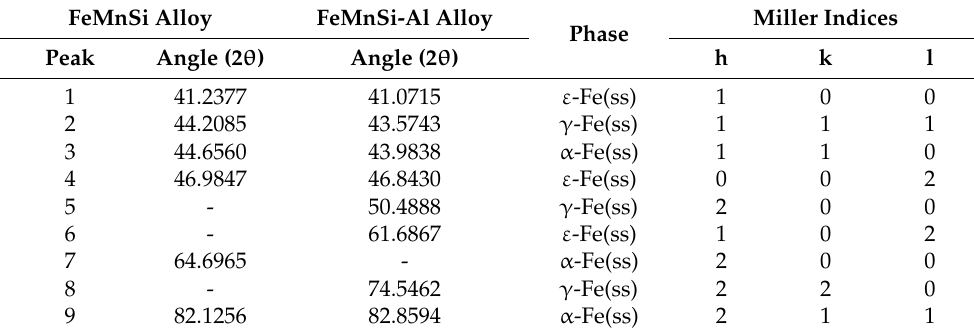
Figure 3. XRD patterns of HR FeMnSi and FeMnSi-Al alloys: ( a ) FeMnSi and FeMnSi-Al diffractograms; ( b ) main peaks (Gauss deconvolution). Table 2. Characteristic diffraction peaks for FeMnSi and FeMnSi-Al alloys.